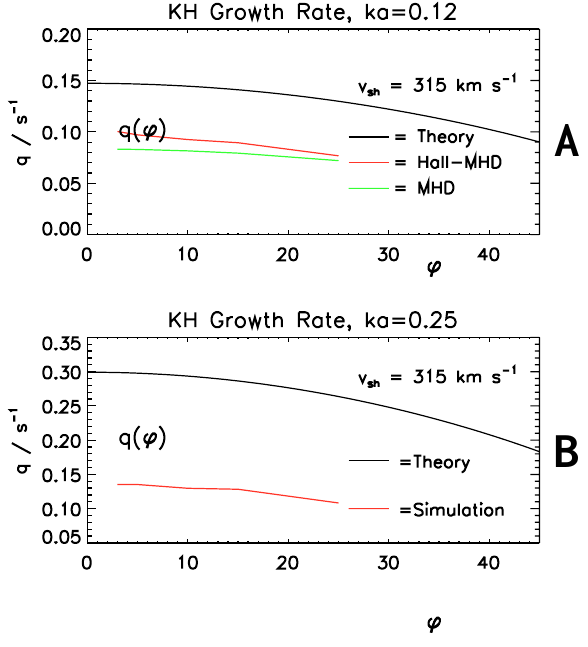
Fig. 12. (A) represents comparison of KH growth rates between linear MHD theory and Hall-MHD and MHD simulations for ka = 2 π/aλ = 0 . 12. (B) shows comparison between KH growth rates between theory and Hall-MHD simulations for ka = 0 .